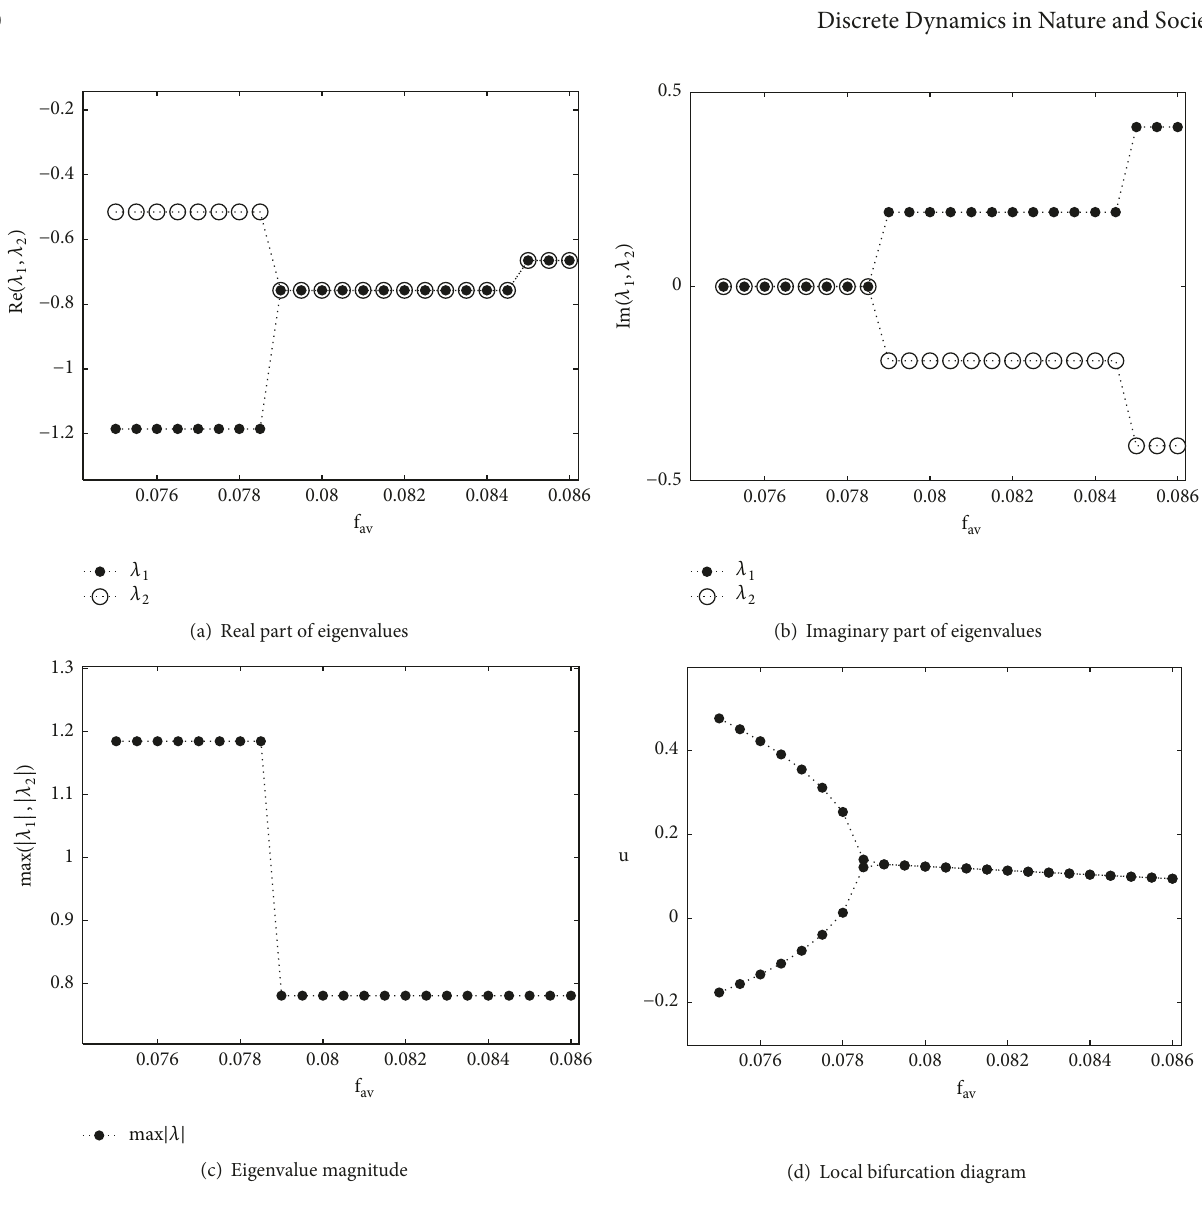
Figure 15: Floquet multiplier map and bifurcation